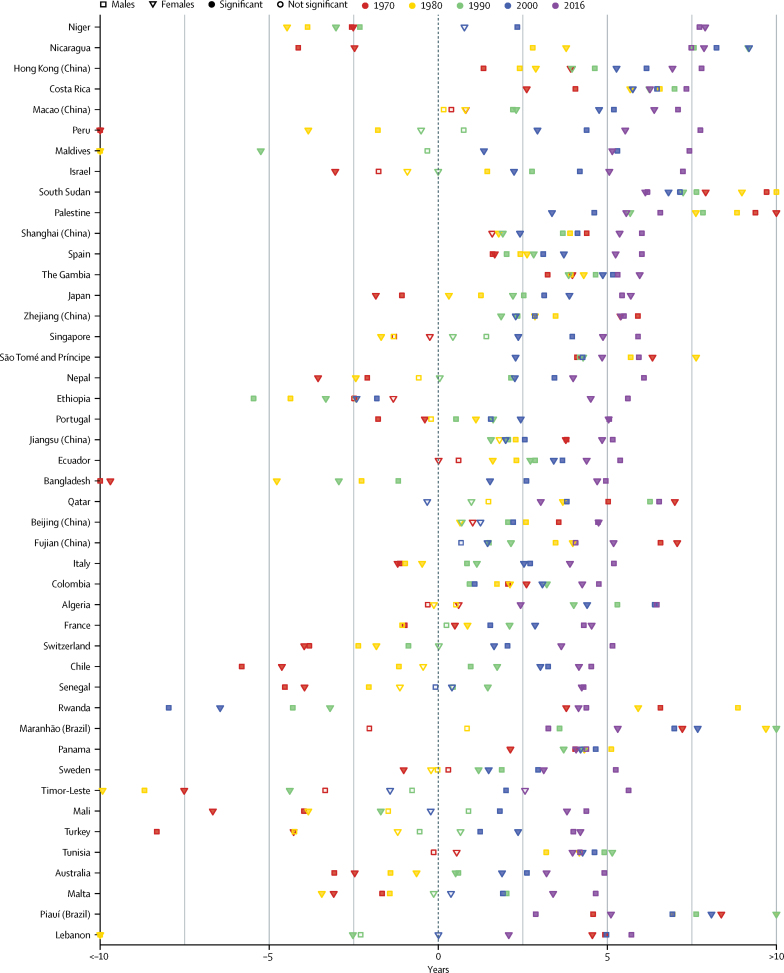
Difference between observed and expected life expectancy at birth on the basis of SDI alone for countries and territories, and subnational units in Brazil, China, India, Indonesia, and the USA, by sex, 1970–2016Each point represents the observed minus the expected life expectancy for each location in the given year, by sex. Points are colour-coded by range of years with squares representing males and triangles representing females. The 0 line represents no difference between observed life expectancy and the value expected on the basis of SDI. Solid points represent significant differences and hollow points represent differences that are not significant. Locations are in decreasing order by average male and female difference between observed and expected life expectancy at birth in 2016. SDI=Socio-demographic Index.